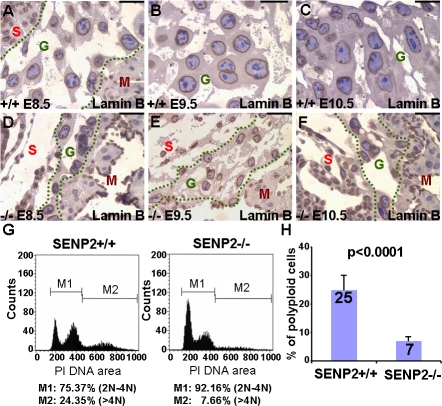
SENP2 Is Required for Trophoblast Maturation(A–F) Immunostaining of the E8.5 (A,D), E9.5 (B,E) and E10.5 (C,F) SENP2+/+ (A–C) and SENP2–/– (D–F) placentas with lamin B, which marks nuclear envelopes, shows the size of nuclei. The TGC layers are defined by broken green lines. The stained (brown) sections were counterstained (blue) with hematoxylin. Note that the SENP2-null TGCs (D–F) contain smaller nuclei with less dotted staining (representing nucleoli and heterochromatin) than the controls (A–C).(G) Endoreduplication is impaired by the loss of SENP2. The SENP2+/+ and SENP2–/– TS cells were induced for differentiation into TGCs in vitro. Flow cytometric analysis of the differentiated SENP2+/+ and SENP2–/– cells, stained with PI, was used to measure their DNA contents (M1, two to four copies; M2, more than four copies). The diagram in (G) is a representative of five independent experiments; the average percentages of the SENP2+/+ and SENP2–/– polyploid cells in all five cultures is presented in (H) (p < 0.0001, n = 5).G,TGC layer; M, maternal decidua; S, spongiotrophoblast layer. Scale bars, 50 μm.